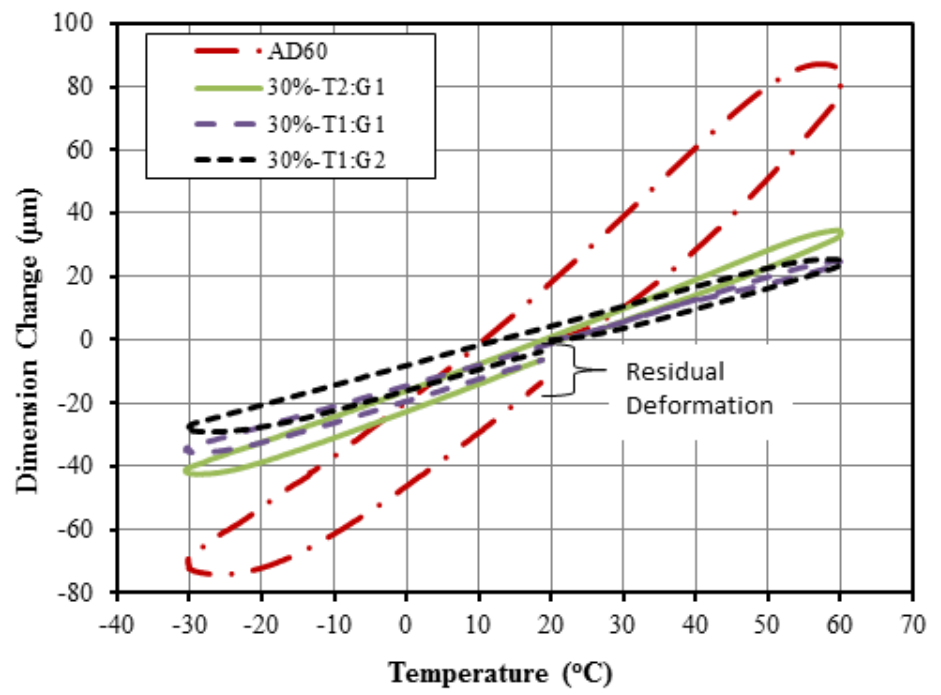
Figure 8. Typical dimension change-temperature history for HDPE AD60 composite filled with combined glassfiber and talc fillers at the 30 wt % loading